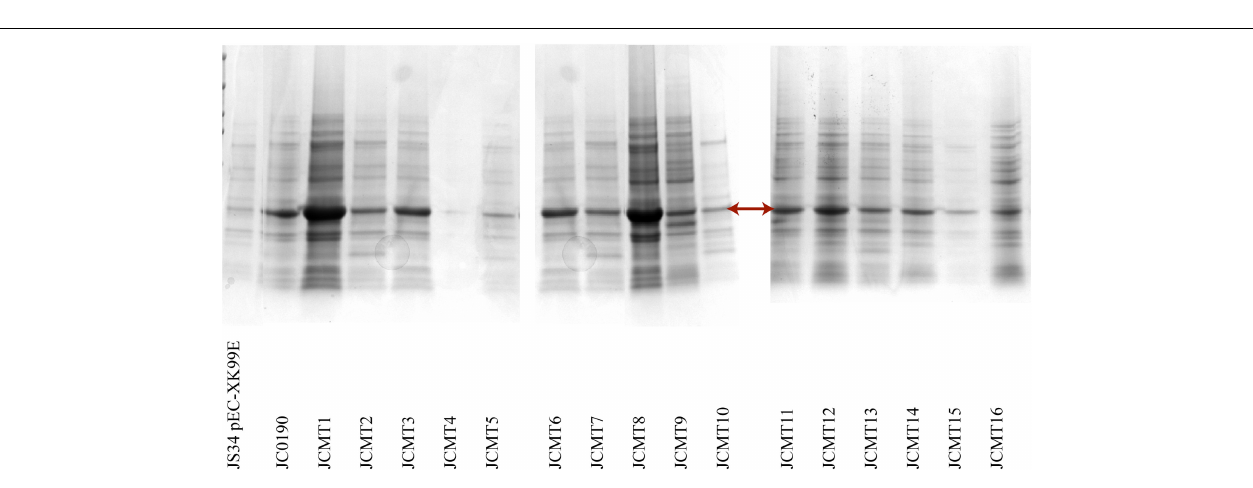
FIGURE 4 | SDS PAGE analysis of the supernatant of the selected mutants. The arrow points the band β -glucosidase. The lanes from left to right are the wild-type strain with empty plasmid, and the reference strain followed by the mutants. 15 µ L of acetone precipitated protein samples were loaded on the